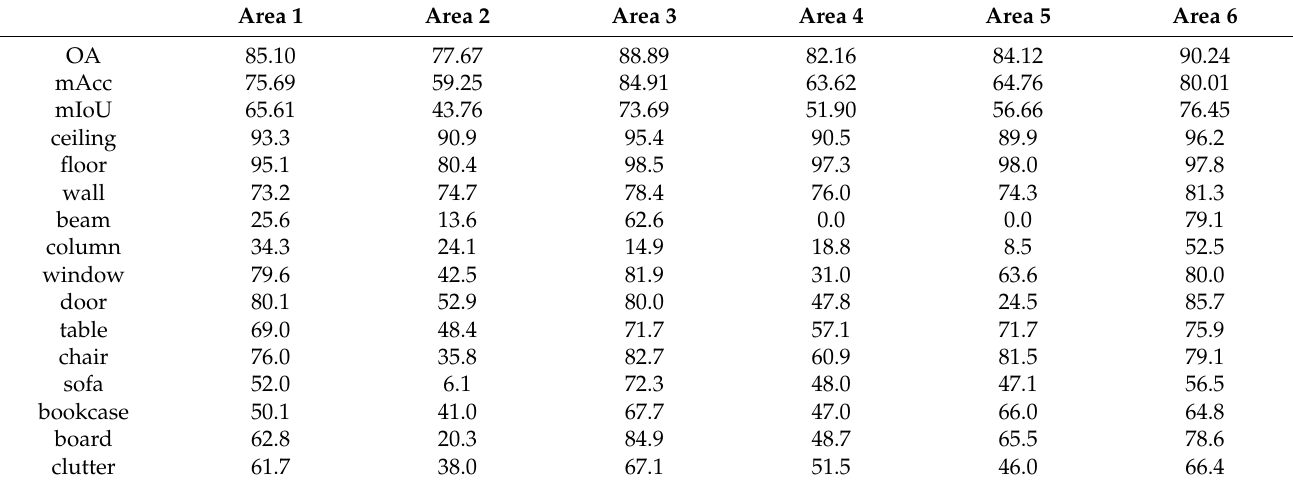
Table 3. Segmentation results for the S3DIS datasets by the HPRS network (%).